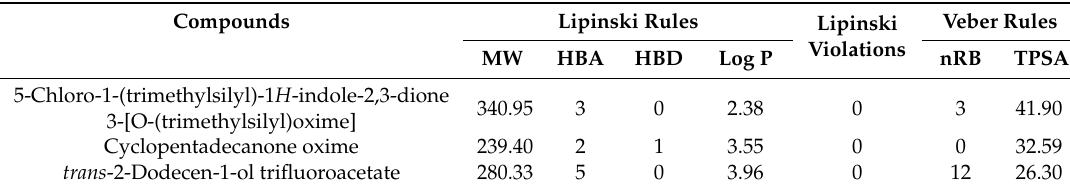
Table 8. ADME / T properties of the selected compounds in MECP by SwissADME. Compounds Lipinski Rules